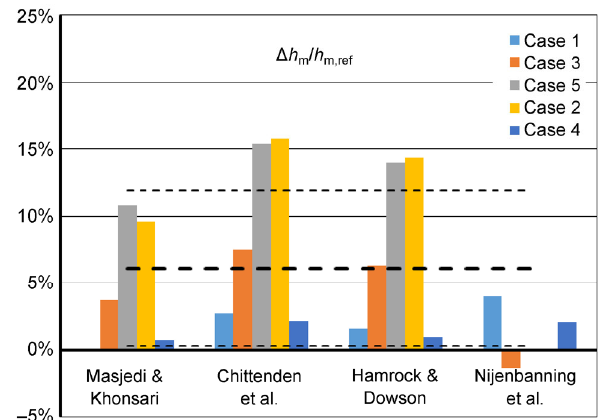
Fig. 5 Relative deviations given by analytical EHD film thickness expressions on h c , the central film thickness, for the 5 wide elliptical reference cases defined by k = 2.92.